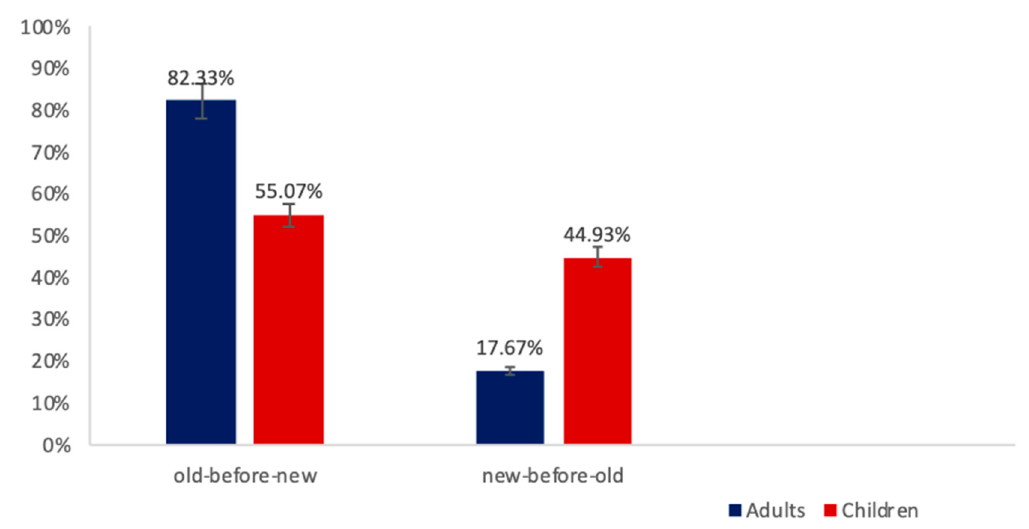
Figure 1. Mean proportions of the “old-before-new” and the “new-before-old” responses in Mandarin child and adult speech.